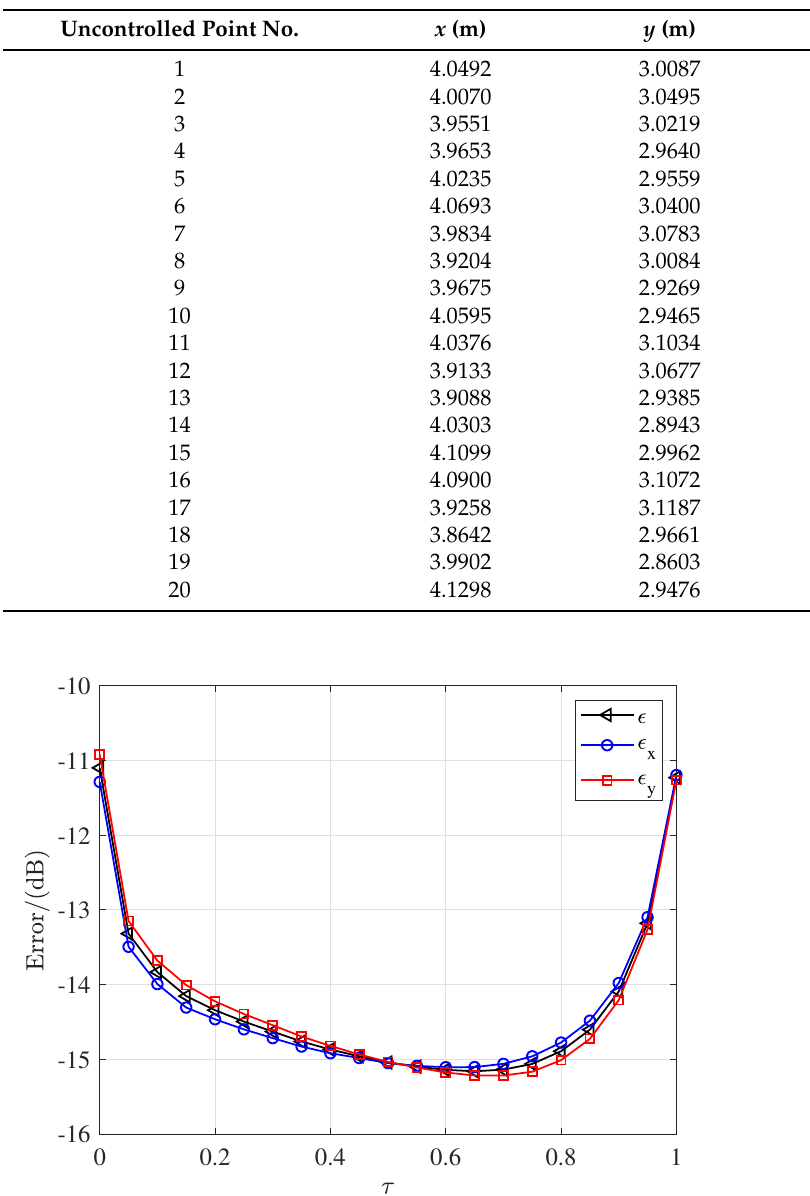
Table 2. The 20 uncontrolled point positions.